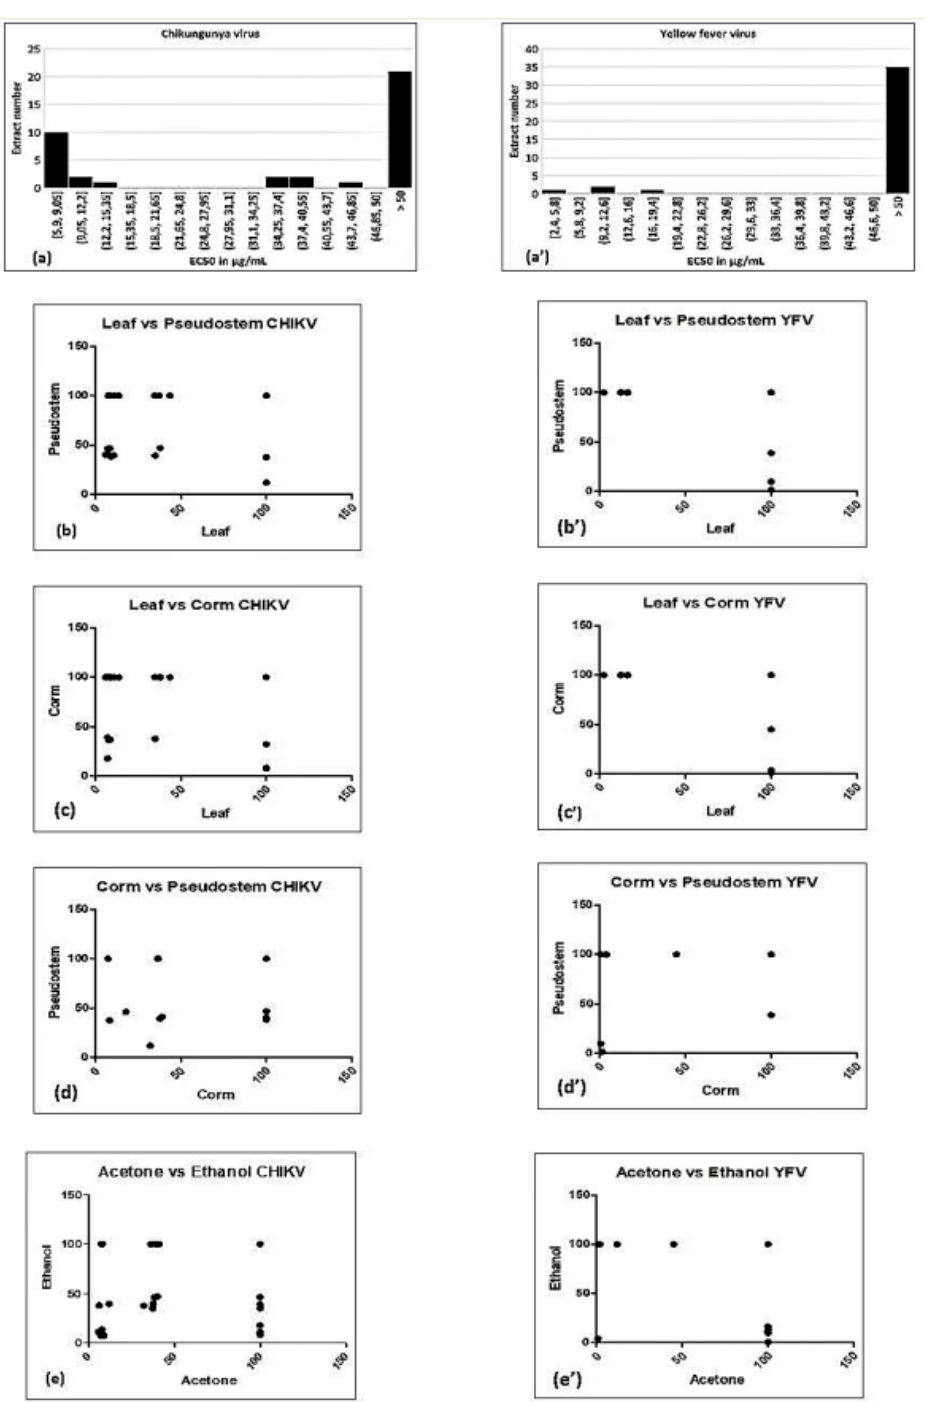
Figure 2. Histogram of EC 50 values ( a , a’ ), and correlation of bioactivity against Chikungunya virus (CHIKV) ( a – e ) or yellow fever virus (YFV) ( a’ – e’ ) between different plant parts ( b – d , b’ – d’ ) and different solvents ( e , e’ ) used to prepare the extracts.